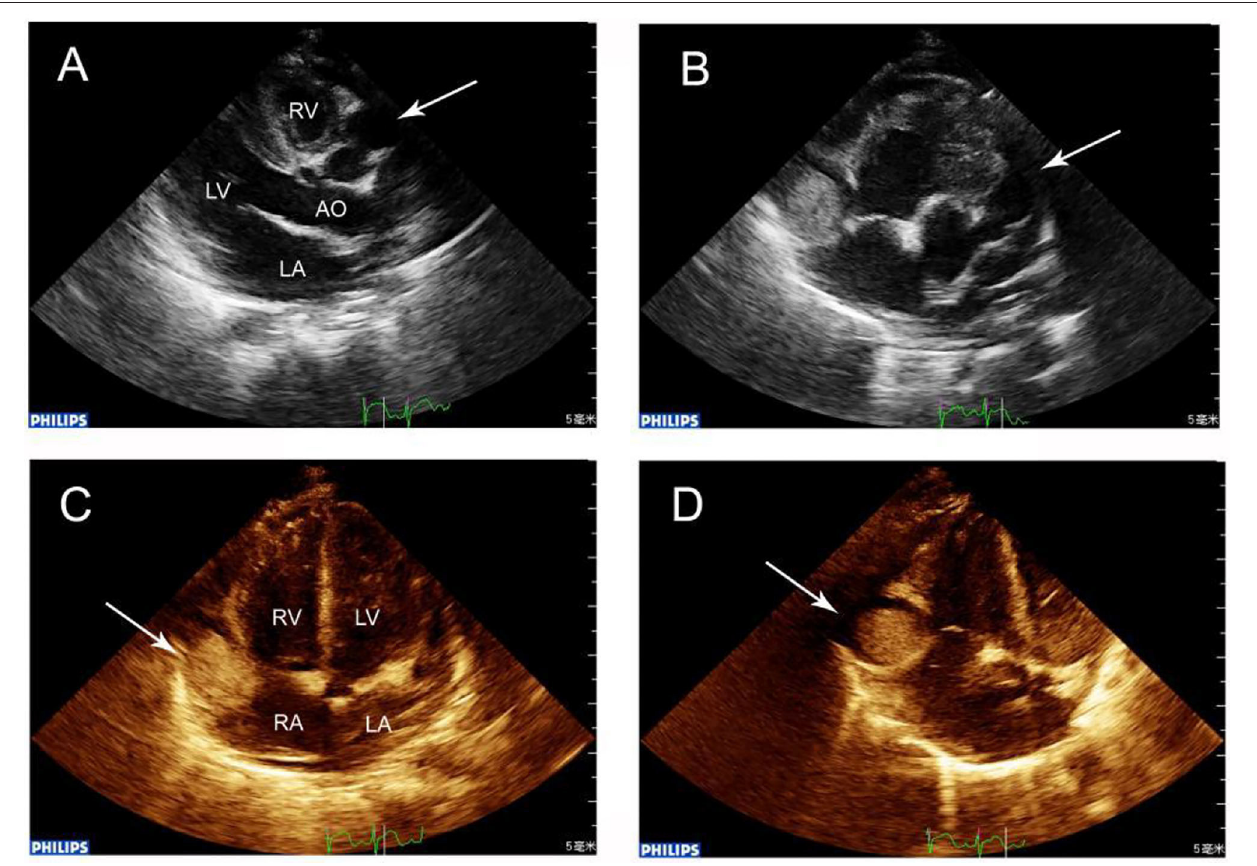
FIGURE 1 | (A) Echocardiography showing RCA dilation (arrow) in the transthoracic long-axis view, showing the characteristic “string-of-beads” pattern. (B) Parasternal shor t- axis view showing a giant aneurysm (maximal diameter, 15.0mm) in the RCA where within 5mm, a thrombus was located. The LCA was also grossly dilated (arrow). (C) Apex four-chamber view revealing RCA that at the right atrioventricular ring had a giant aneurysm containing a thrombus (arrow). (D) In the giant aneurysm, a 13.0 × 13.0 mm thrombus was observed in echocardiography (arrow).